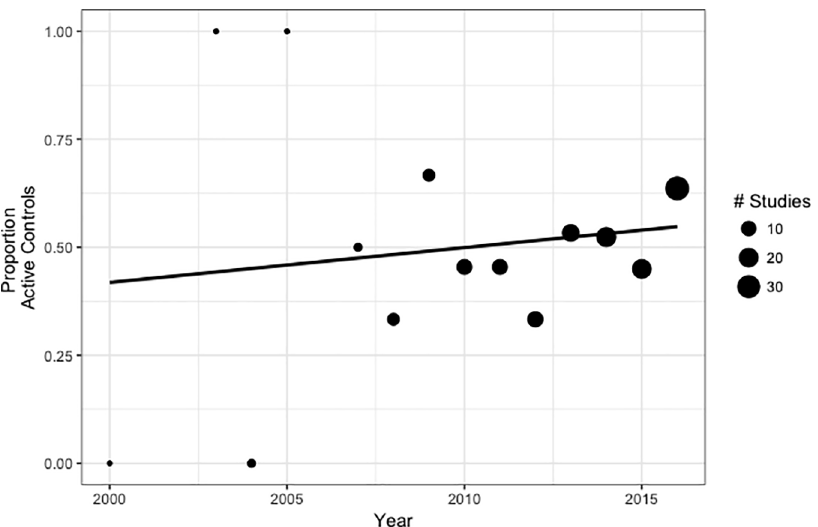
Fig 2. Proportion of studies using active control conditions over time. The size of each point is relative to the number of studies represented.